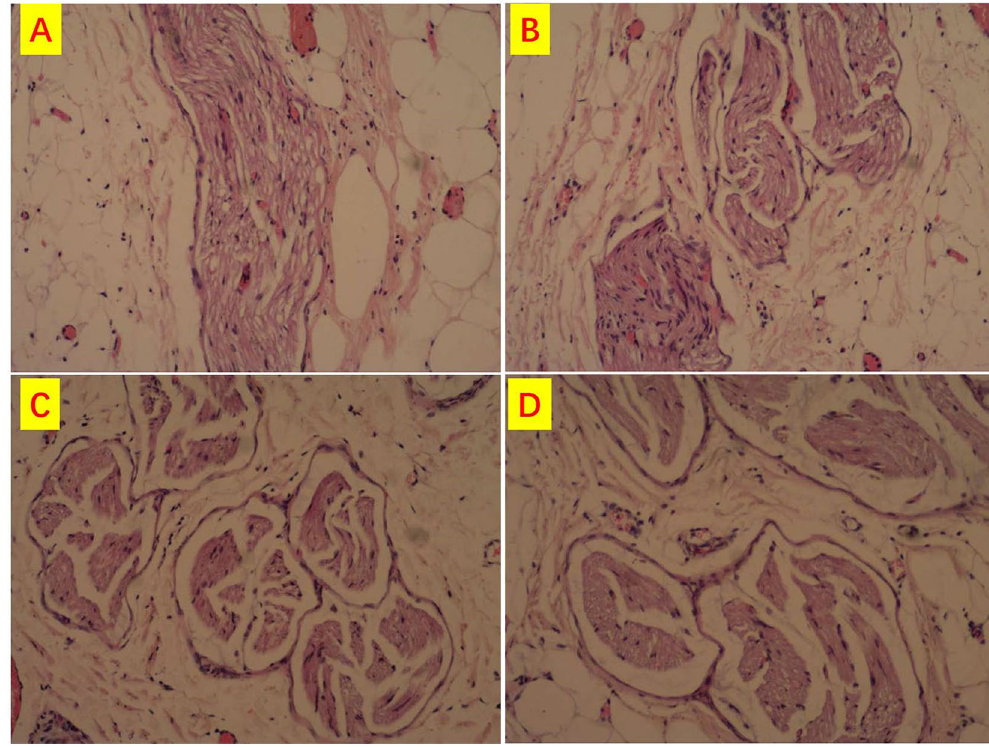
Figure 8. RLN consecutive longitudinal and transverse histological sections (HE x100). RLNs structure were preserved with normal axons, no fibrosis, and no vacuolization and without loss of myelinated fibres. ( A ) Group I,